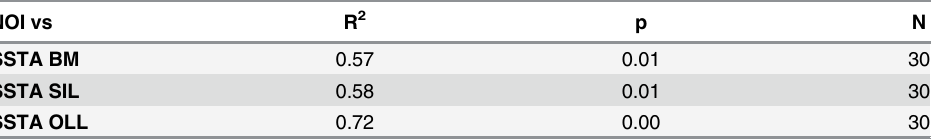
Table 3. Correlation coefficient (R 2 ) between sea surface temperature anomalies and ENSO index. Sea Surface Temperature Anomalies (SSTA) in the oceanic area at the entrance of (from south to north):